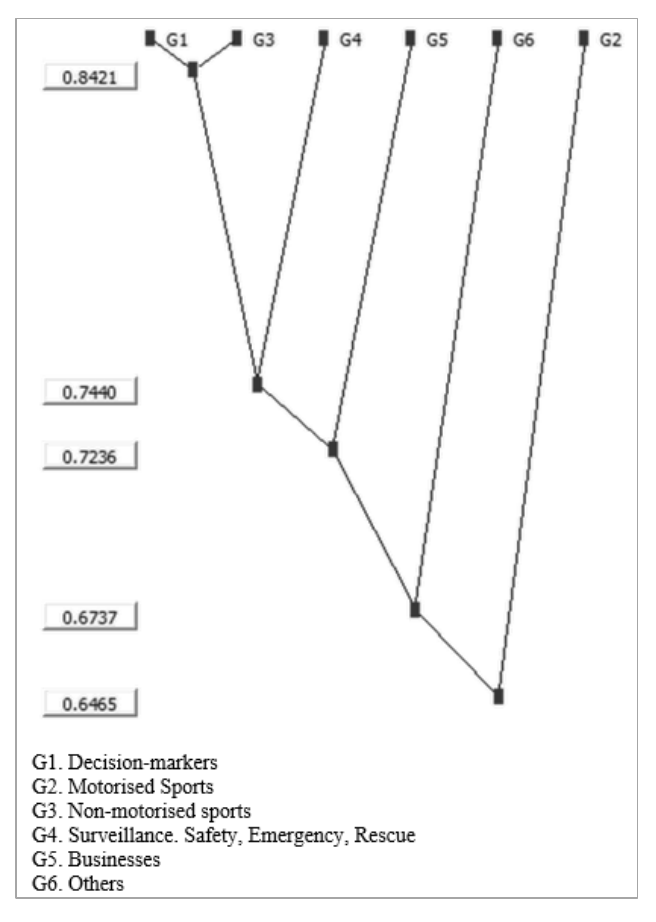
Figure 6. Dendrogram of stakeholder groups on forest management